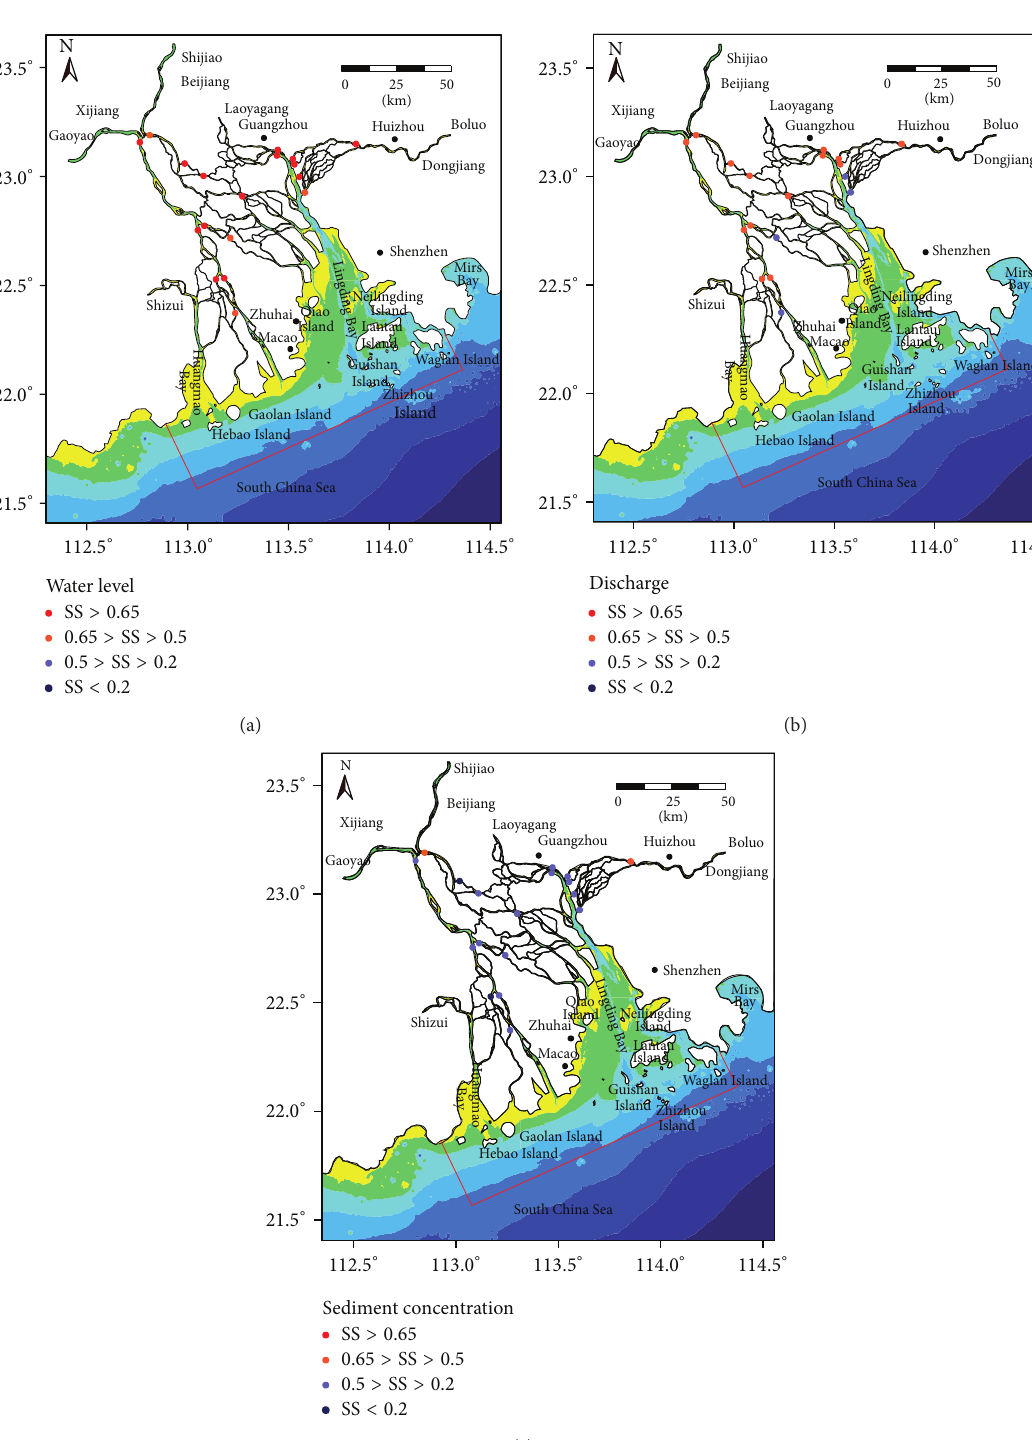
Figure 3: The coupled model uses the field measurements from July 18, 1998, to July 19, 1998 (wet season), at eighteen stations as calibration. Themodelskillscoreisemployedtoevaluatequantitativelythemodelperformanceofwaterlevels(a),discharges(b),andsuspendedsediment concentration (c) against the measured time series. The circles with the different colors represent the different performances of the model. The high scores of the water levels and the discharges show the good performance of the model, which include the contribution of the calibration of the suspended sediment